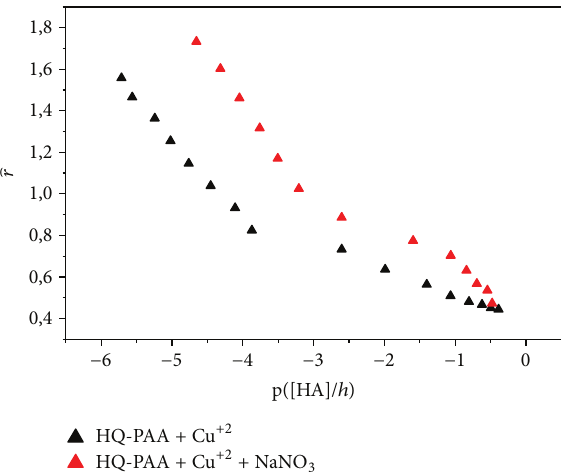
Figure 11: Plots of